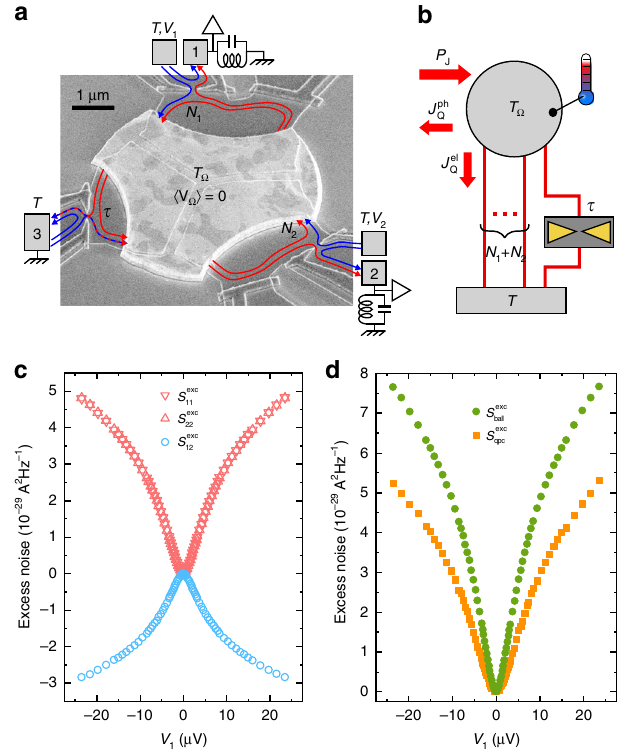
Fig. 1 Experimental approach. a Device e-beam micrograph with measurement setup schematic. A single generic channel of arbitrary electron transmission probability τ , as well as N 1 and N 2 ballistic (perfectly transmitted) channels, are separately connected to a small metallic island. b Schematic heat balance representation between injected Joule power ( P and outgoing heat currents, from electrons to phonons ( J ph Q ) and through the connected electronic channels ( J el Q ). c Excess auto- and cross- correlation measurements versus V 1 ¼ (cid:3) V 2 , in the illustrative con fi guration N ¼ 2 ( N N τ (cid:4) 0 : 5. d Extracted excess noise sources per 1 ¼ 2 ¼ 1), ballistic channel ( S exc ) and across the generic single-channel quantum point ball contact of transmission τ ( S exc ), from the data in c qpc